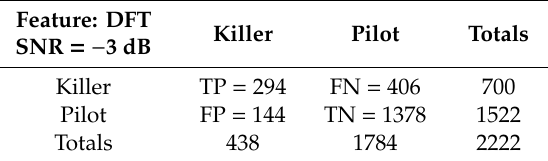
Table 13. Classification results: DFT, SNR = − 3 dB.